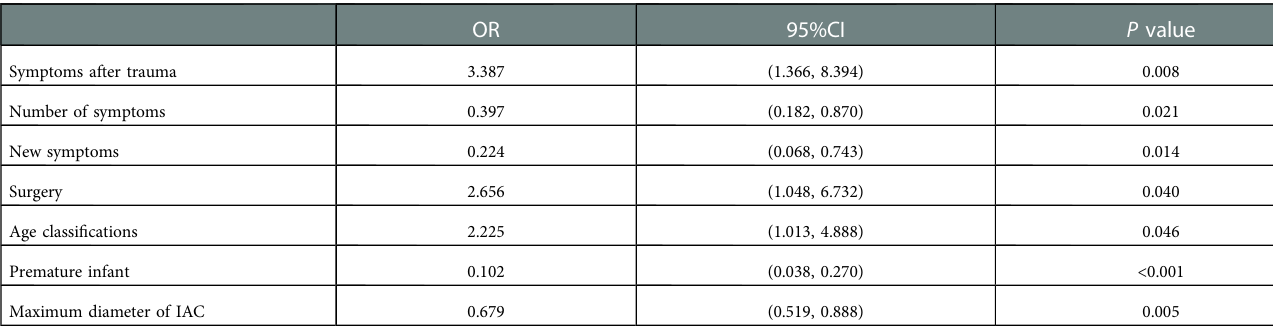
TABLE 3 Results of Binary logistic regression